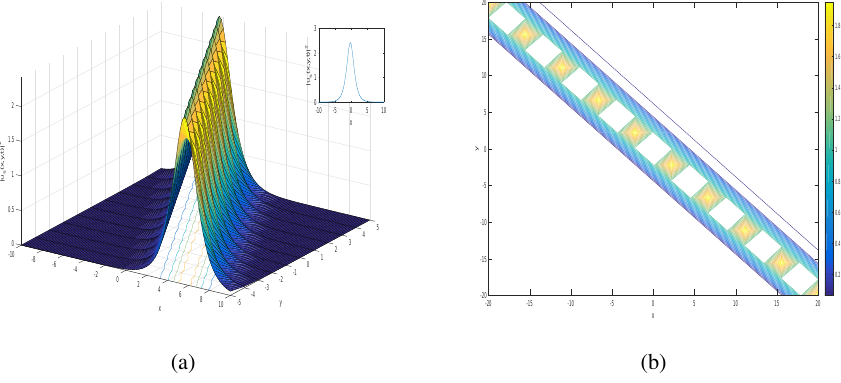
Figure 2 The (a) 3D, 2D surfaces (b) contour plot of Eq. (3.20).